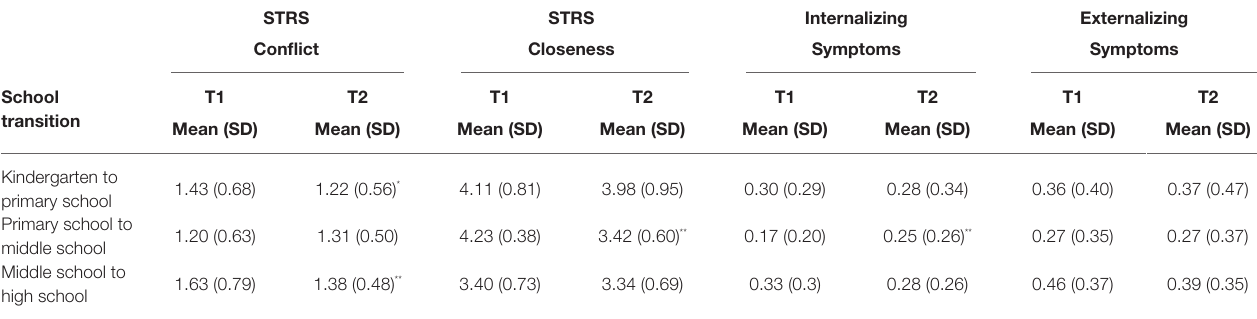
TABLE 1 | Descriptive statistics and paired samples t -tests for student-teacher relationship and student psychological symptoms during normative school transitions.